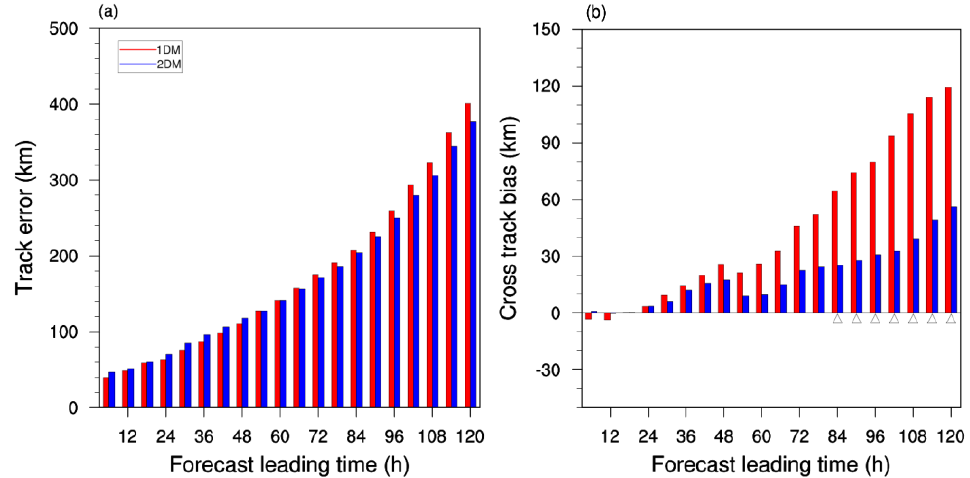
Figure 4. Absolute track error ( a ) and cross-track bias ( b ) averaged for the 107 forecasts listed in Table 1. The triangles denote that the difference is significant at a 90% confidence level.